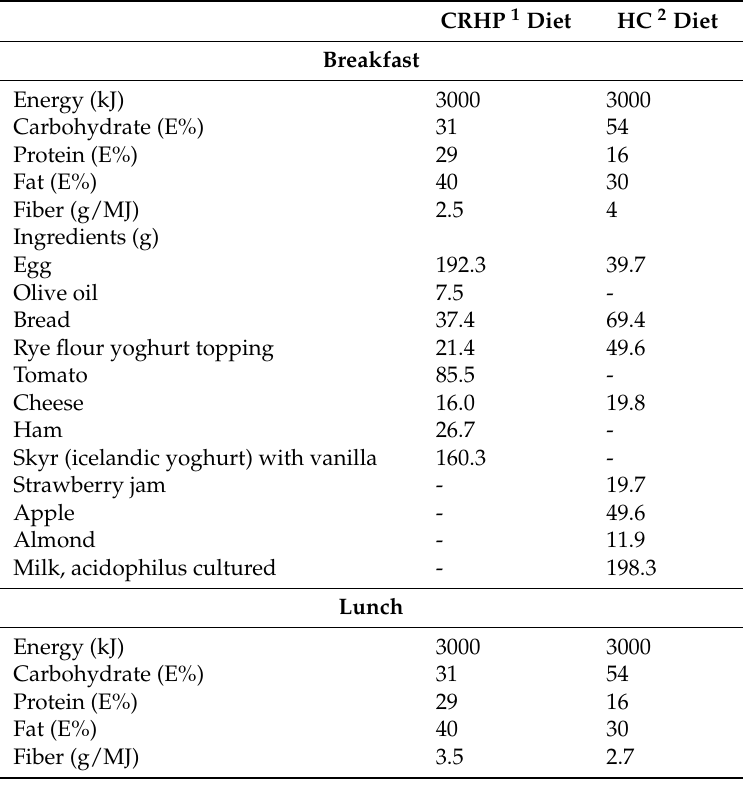
Table A1. Macronutrient composition and ingredients of the test meals standardized at 10